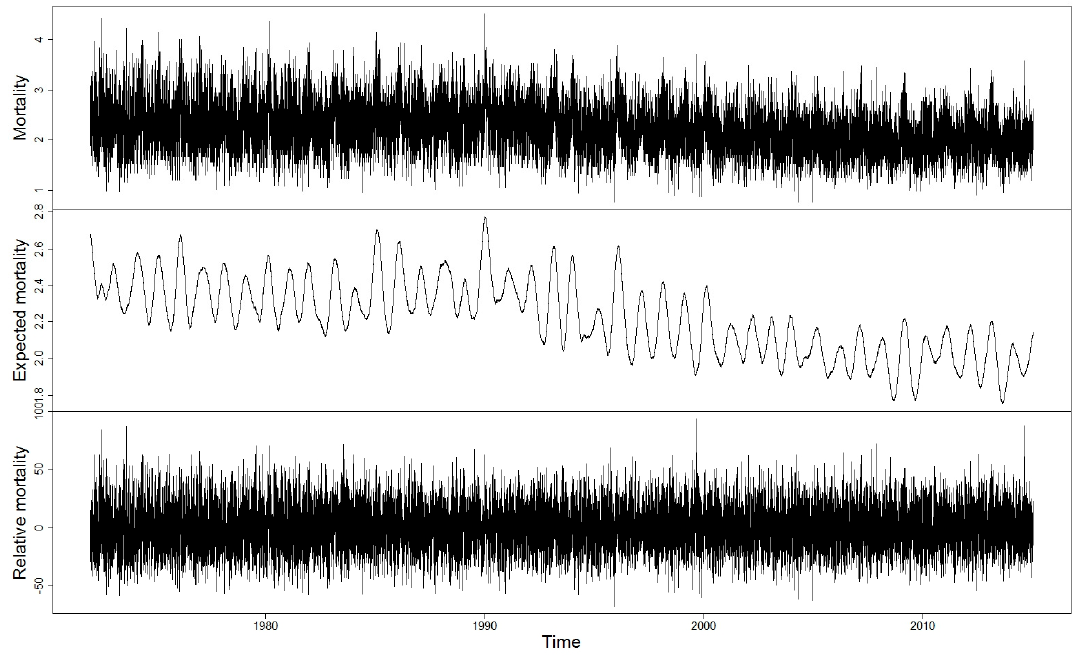
Figure 1. Time series of mortality (1/100,000) (upper panel), expected mortality (1/100,000) (middle), and relative mortality (%) (lower panel) in Helsinki-Uusimaa hospital district, 1972–2014. All-cause deaths and all age groups.